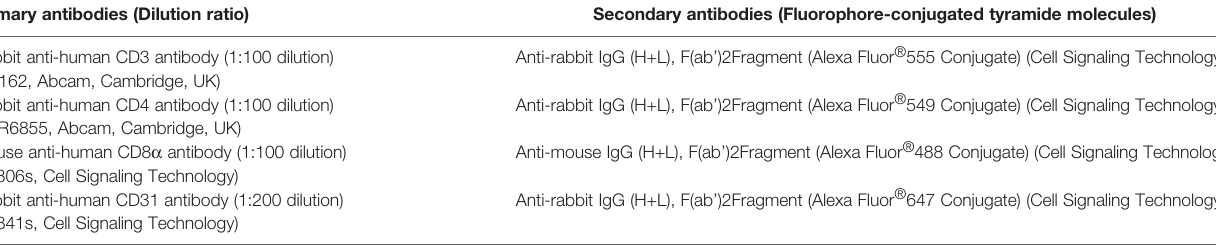
Anti-rabbit IgG (H+L), F(ab ’ )2Fragment (Alexa Fluor ® 555 Conjugate) (Cell Signaling Technology) Anti-rabbit IgG (H+L), F(ab ’ )2Fragment (Alexa Fluor ® 549 Conjugate) (Cell Signaling Technology) Anti-mouse IgG (H+L), F(ab ’ )2Fragment (Alexa Fluor ® 488 Conjugate) (Cell Signaling Technology) Anti-rabbit IgG (H+L), F(ab ’ )2Fragment (Alexa Fluor ® 647 Conjugate) (Cell Signaling Technology)